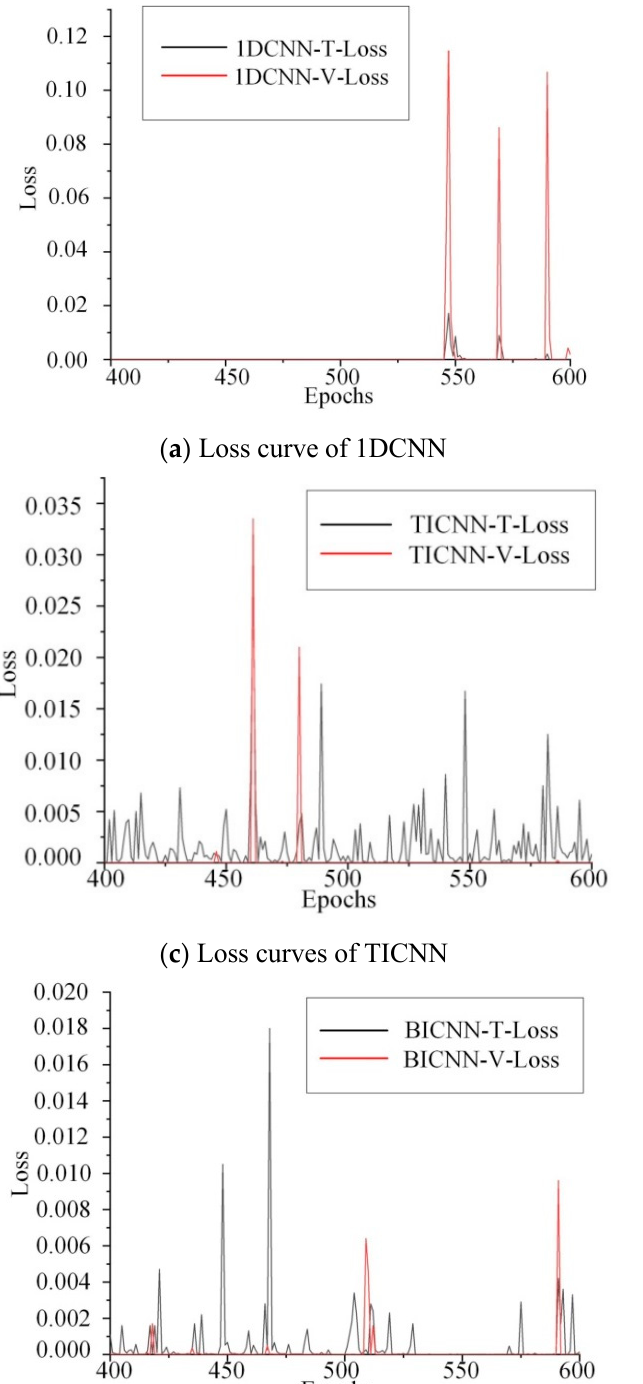
Figure 6. Loss curves of 1DCNN, WDCNN, TICNN, ITICNN and BICNN. In Figure 6, BICNN-T-Loss is the change curve of Loss obtained by training with BICNN; BICNN-V-Loss is the change curve obtained by testing with BICNN. When 1DCNN, TICNN, WDCNN and ITICNN were used for training and testing, the change curve of Loss obtained also adopted the same expression. As shown in Figure 6, five networks are used to train the data collected by the acceleration sensor numbered 9 for 600 epochs at the same time, and 400~600 epochs are taken for comparison. When using 1DCNN for training and testing, Loss experienced three large fluctuations with ampli- tude greater than 0.09. When using WDCNN for training and testing, Loss experienced one large fluctuation with amplitude greater than 0.018. When using TICNN for training and testing, Loss experienced five large fluctuations; the maximum amplitude of Loss is about 0.033, and the minimum amplitude is about 0.015. When using ITICNN for train- ing and testing, Loss experienced one large fluctuation with amplitude greater than 0.08. When using BICNN for training and testing, Loss experienced three large fluctuations with amplitude of 0.011, 0.018 and 0.011. Therefore, from the above data, it can be seen that compared with 1DCNN, TICNN and ITICNN, the Loss curves of WDCNN and BICNN are relatively stable and have stronger fitting ability. 4.6. Visualization Analysis of BICNN’s Performance TSNE cluster is a commonly used method to reduce dimensions. It can convert the output dimensions of specified layers, such as full connection layer, into a one-dimensional scatterplot, and the changes of data sets in the network can be intui- tively shown. In order to more intuitively express the damage location diagnosis results of structural frame, TSNE cluster was used to visualize the diagnosis results. Under the